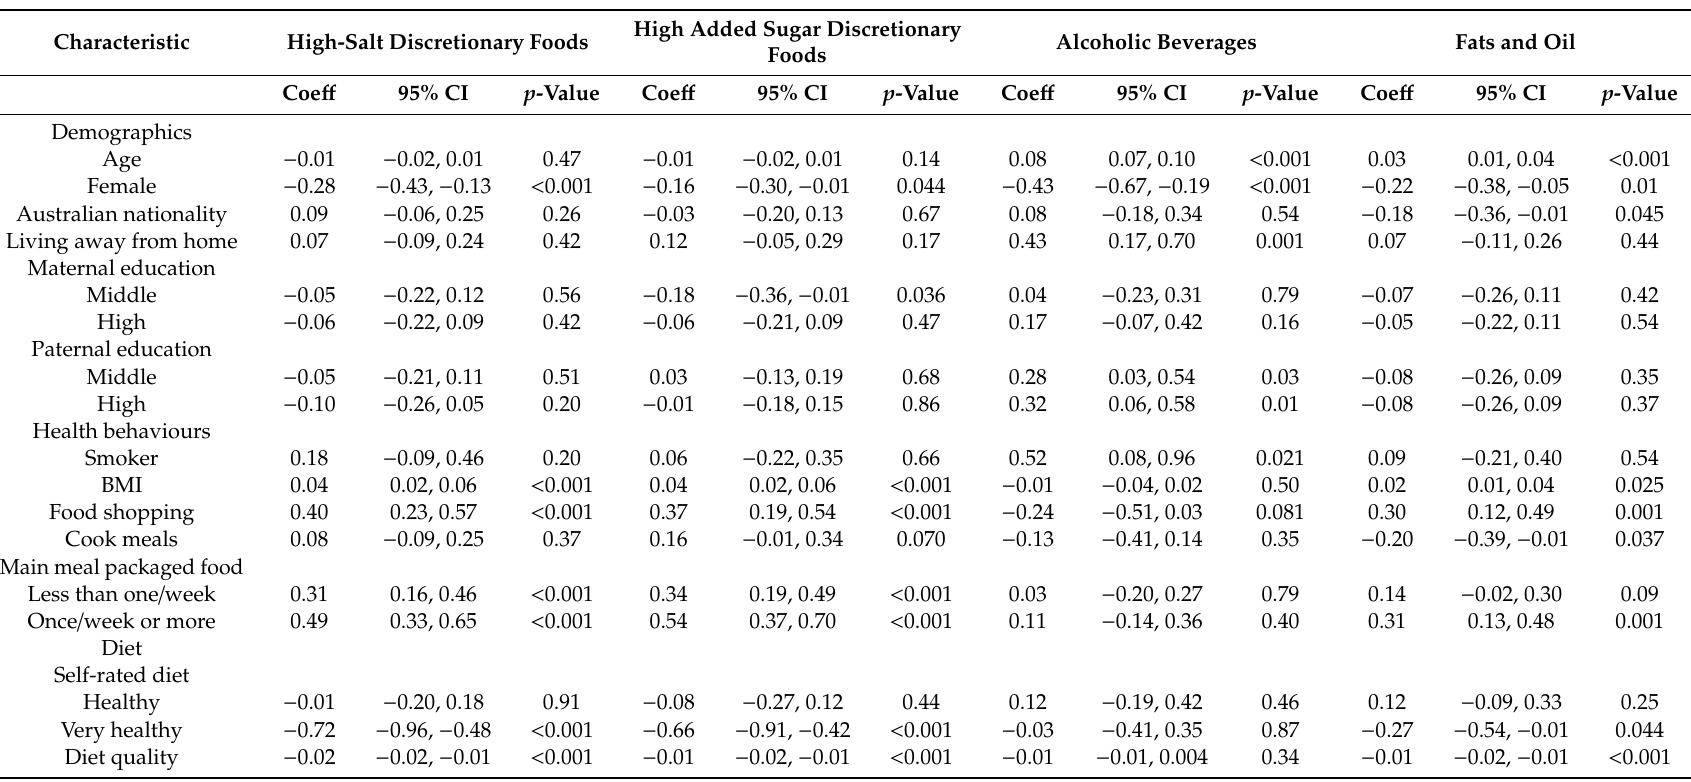
Table 5. Multiple linear regression analysis for the association of liking discretionary foods with demographics, health behaviours, diet quality and anthropometrics in young Australian adults ( n =